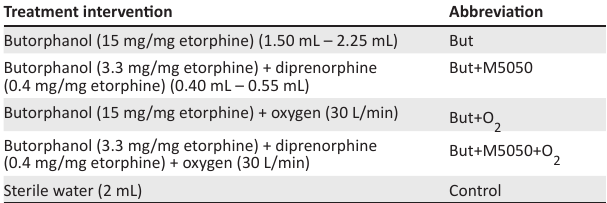
TABLE 1: Drugs and doses used to treat respiratory impairment in the rhinoceros. Treatment